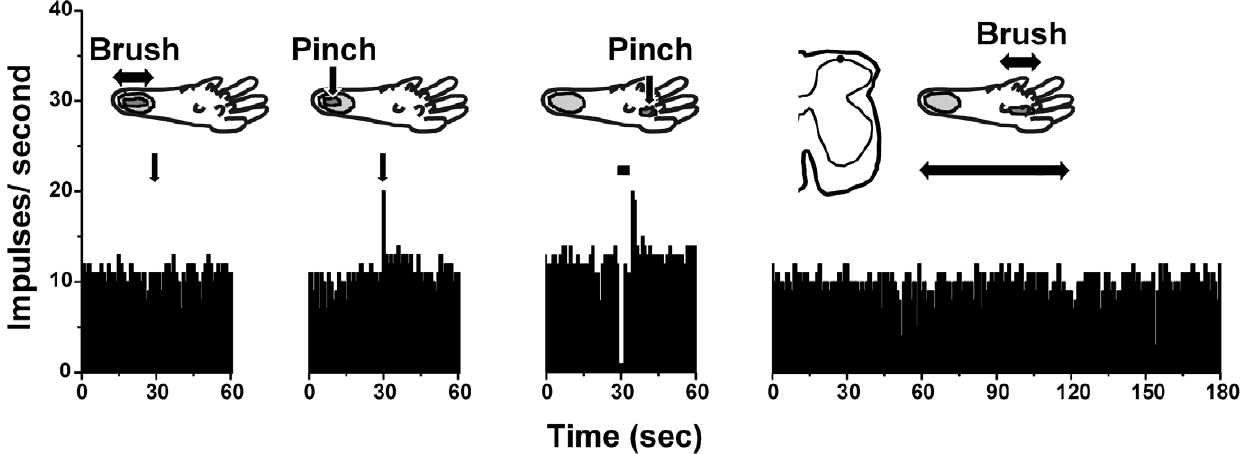
Figure 4. Pinch-evoked inhibition of spinal neuronal firing. PSTHs (bins: 1 sec) show responses of a superficial dorsal horn unit to brush and pinch stimuli delivered either within (2 left-hand PSTHs) or outside (2 right-hand PSTHs) the receptive field on the heel (gray area). The unit was excited by pinch but not brush within the receptive field, and was inhibited by pinch but not brush stimulus to outside receptive field.